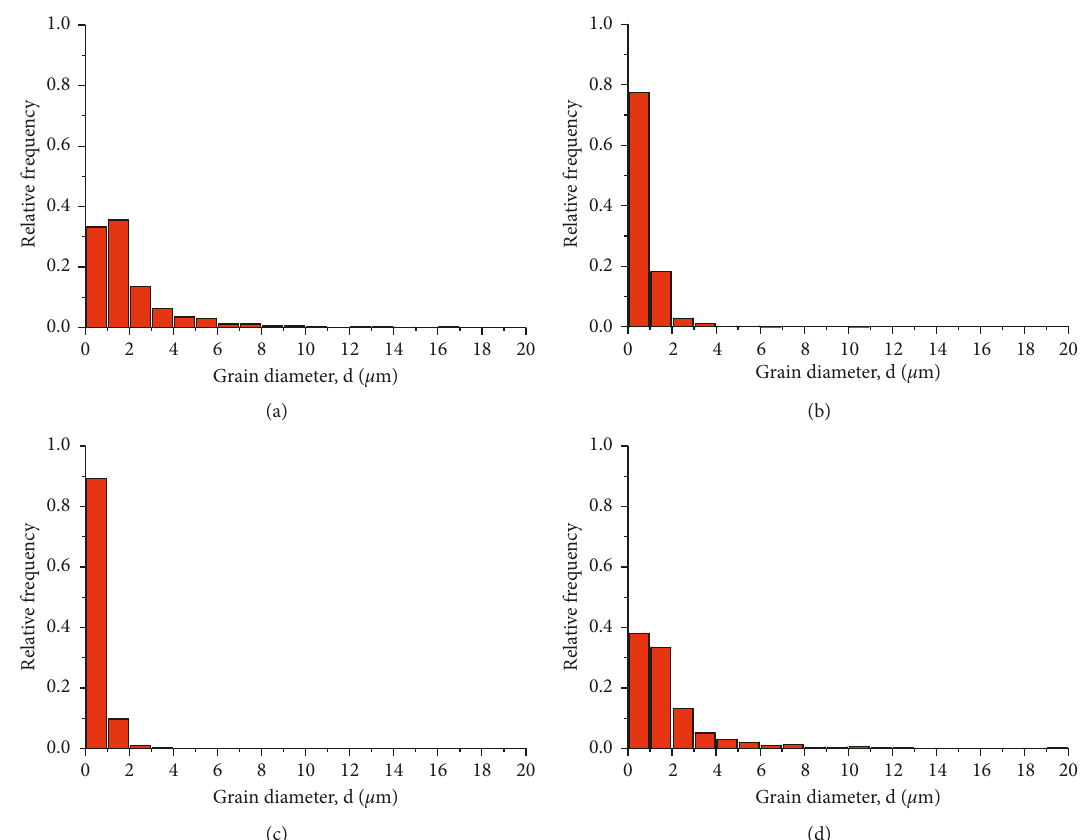
Figure 4: Grain diameter distribution in (a) region 1 of sample 1, (b) region 2 of sample 2, (c) region 3 of sample 3, and (d) sample